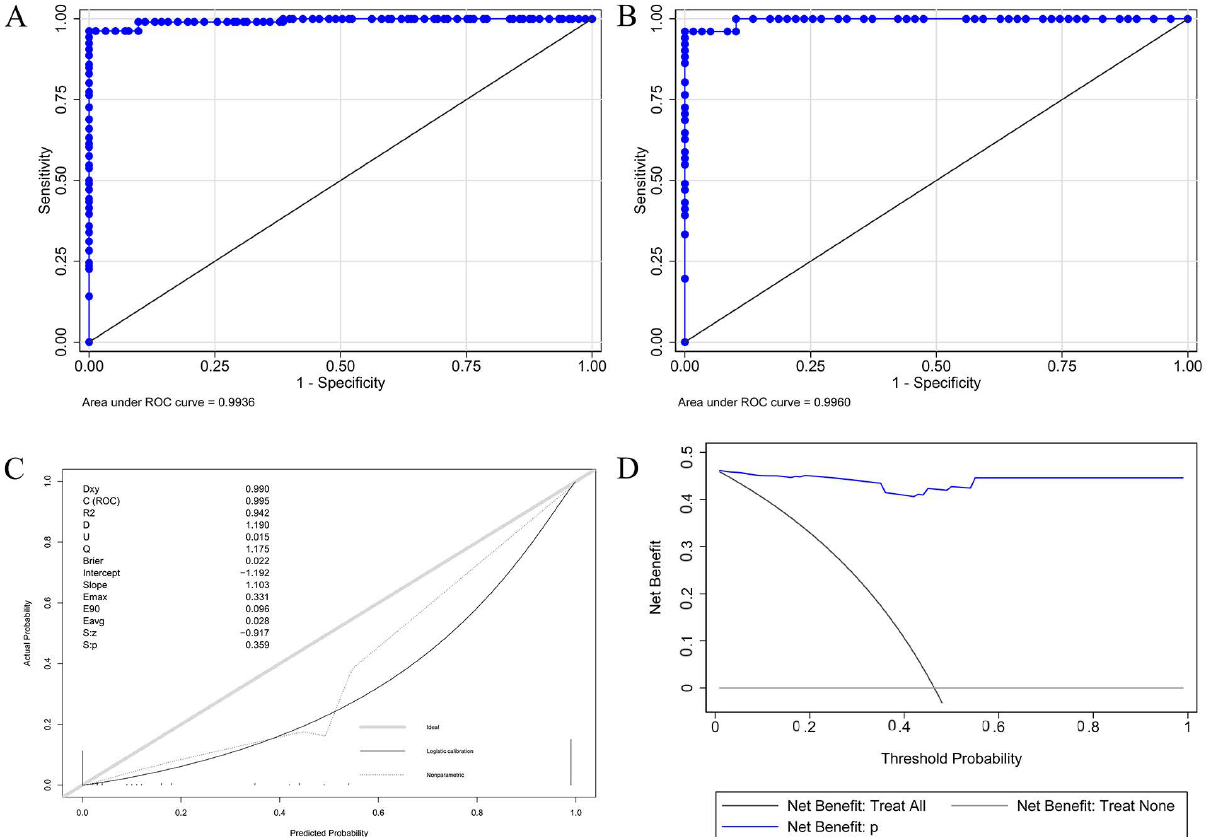
Figure 5. AUROC, calibration plot and decision curve analysis for the model. ( A ), AUROC in the development cohort; ( B ), AUROC in the validation cohort; ( C ), Calibration Plot shows the relationship between the predicted probabilities based on the nomogram and the actual values of the validation cohort. A plot along the 45-degree line would indicate a perfect calibration model in which the predicted probabilities are identical to the actual outcomes; and ( D ), Decision Curve Analysis: The y -axis measures the net benefit. The blue line represents the nomogram. The black line represents the assumption that all patients experience blood pressure change failure. The thin grey line represents the assumption that no patients experience blood pressure change failure. AUROC represents the discrimination ability of the model measured by the concordance index. Abbreviations: AUROC, area under the receiver operating characteristic